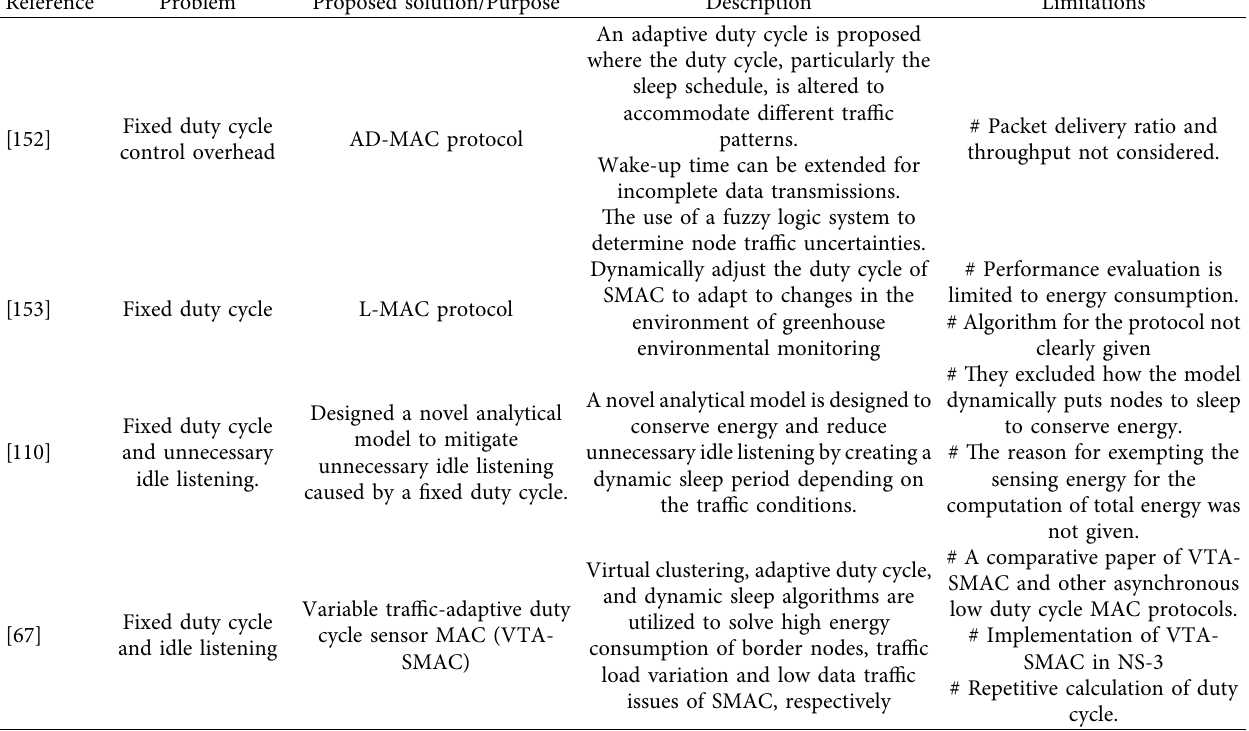
Table 6: Enhanced protocols/algorithms for fixed duty cycle limitation of SMAC